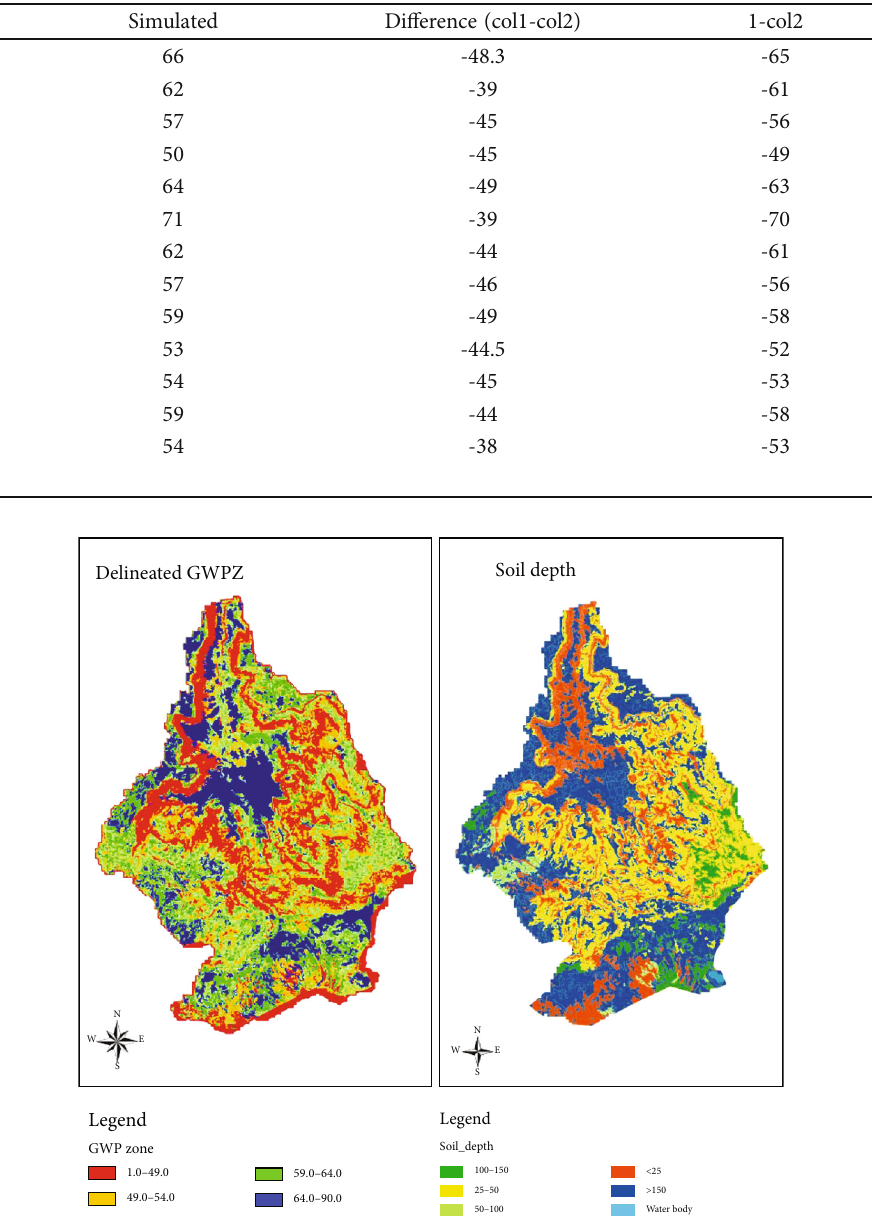
Table 7: Kappa statistics